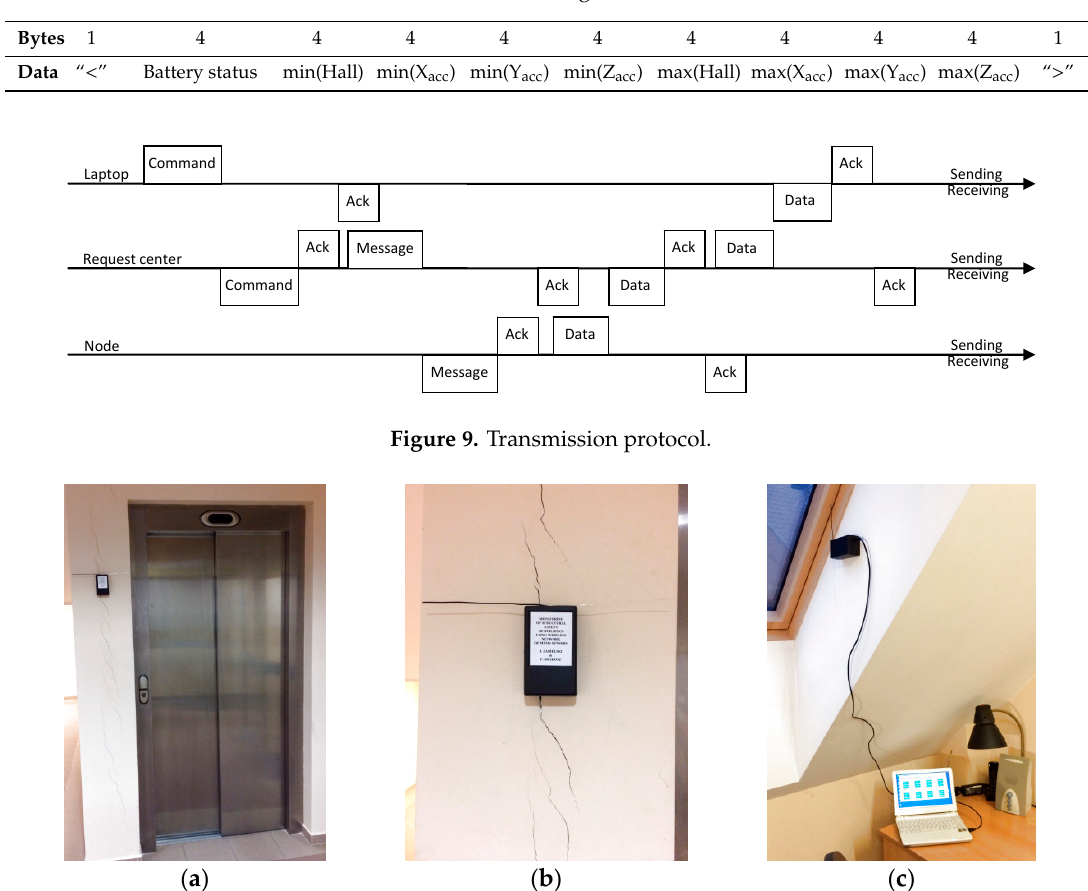
Figure 8. Algorithm of the program running on the sensor node. Table 1. Message frame.